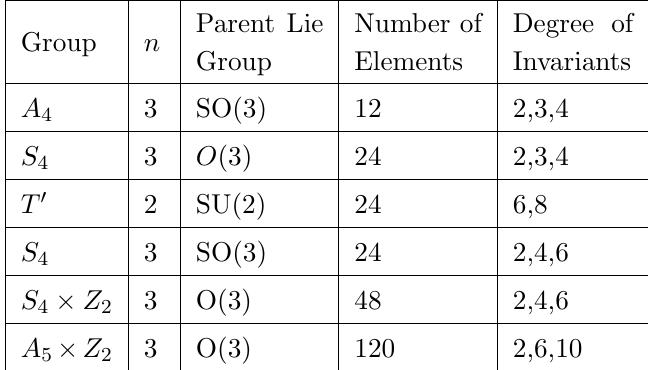
Table 1. Degree of Polynomial invariants for a few groups. n is the dimension of the representation under consideration. For subgroups of SO(3) or SU(2), the theorem doesn’t apply. First three groups are isomorphic to tetrahedron, next two to Cube or Ocathedron. A 5